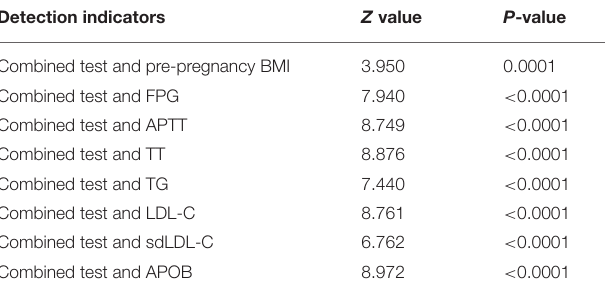
TABLE 6 | Comparison of AUC areas for pre pregnancy BMI, FPG, APTT, TT, TG, LDL-C, sdLDL-C, APOB and combined test in GDM and non-GDM